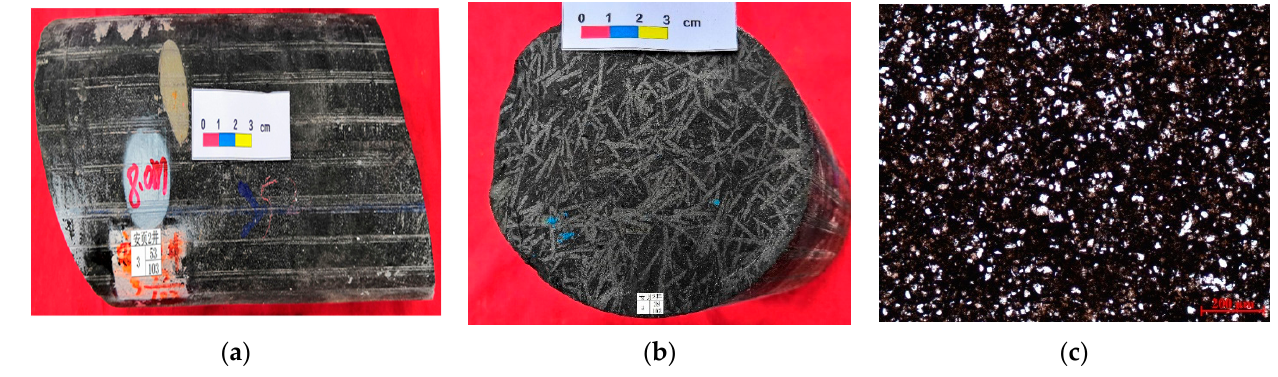
Figure 3. Shale cores of the Wufeng–Longmaxi Formation in the Anchang Syncline. ( a ) The recovered full-diameter shale core from the Longmaxi Formation, depth = 1964.79 m; ( b ) abundant graptolites in the shale core; and ( c ) quartz particles (white) in the shale core observed using a polarizing microscope. The X-ray diffraction results show that quartz dominates in the shales from the Wufeng– Longmaxi Formation at the Anchang syncline. There is also a certain amount of clay minerals, feldspar, calcite, etc. (Figure 4). The quartz content ranges between 50% and 65.1%, with an average of more than 57%. The clay mineral content of the investigated shales is between 19% and 45%, with an average of 27.5%. The carbonate content is low, ranging from 0.7% to 9.7%. Only minor shale samples near the Guanyinqiao section have a high carbonate content. Shale samples in the Anchang syncline are rich in pyrite with an average content of about 3.5%. The clay minerals are mainly illite/smectite mixed clay, followed by illite and a little chlorite. In general, the quartz content of gas shales from the Wufeng–Longmaxi Formation in the Anchang syncline is higher than gas shales from the Jiaoshiba block, a national demonstration plot for developing shale gas inside the Sichuan Basin. Even the quartz content of these studied shales is a little higher than the siliceous shales in the lower member of Longmaxi Formation in the Jiaoshiba block (about 49% on average) [30,31], which is considered as the preferential section for the effective development of shale gas.